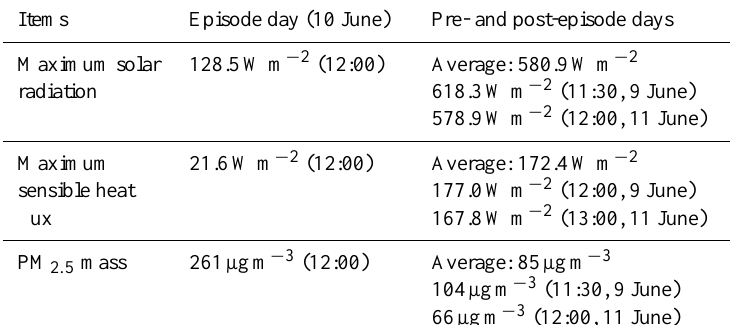
Table 1. Solar radiation, sensible heat flux and PM 2 . 5 mass for episode and non-episode days.